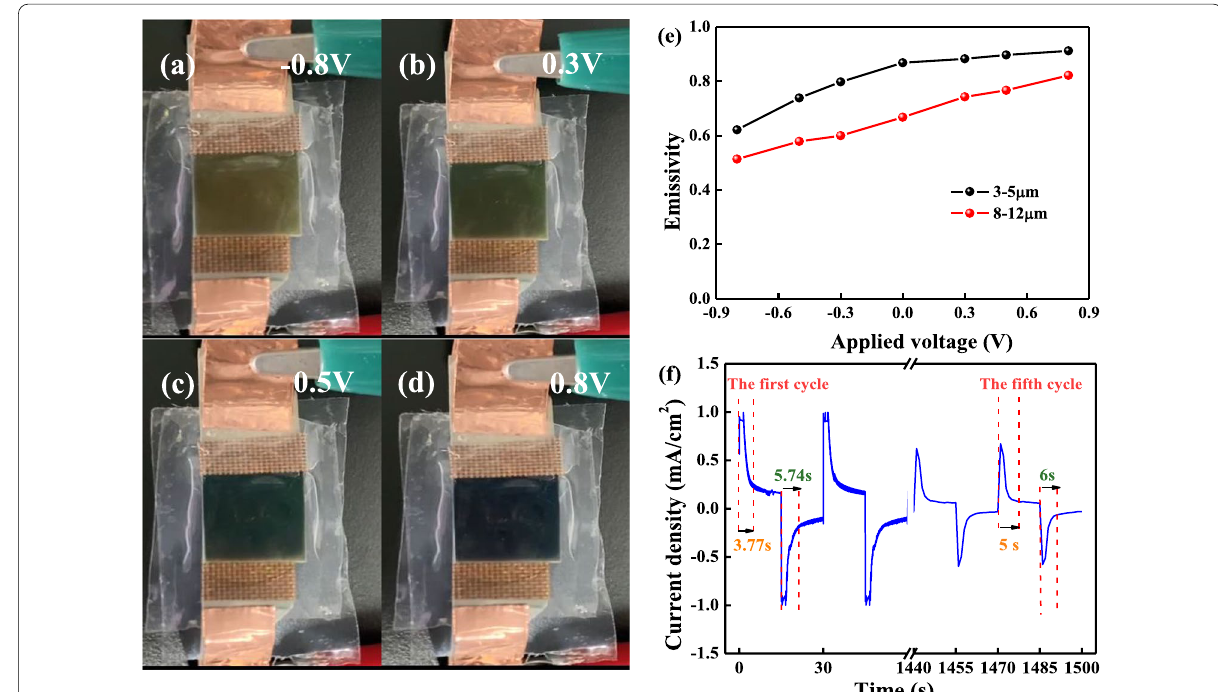
Fig. 9 a – d Digital camera images of Cu-doped PANI IR electrochromic device at different voltages. e The emissivity value ( ε ) of Cu-doped PANI IR electrochromic device at regions of the spectrum (3–5 µm and 8–12 µm). f The CA curves of 1st and 50th cycles of the Cu-doped PANI IR electrochromic device at 0.8 V and -0.8